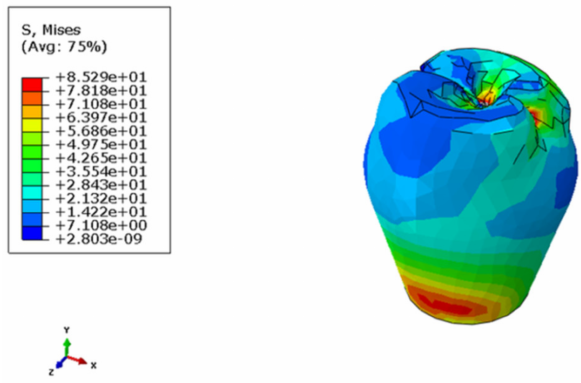
Figure 5. Stress distribution in the crown.